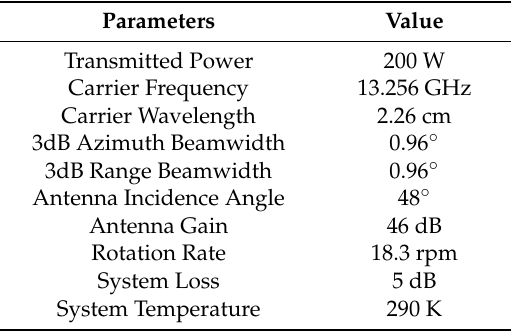
Table 2. Main parameters of the Ku-band DopScat.